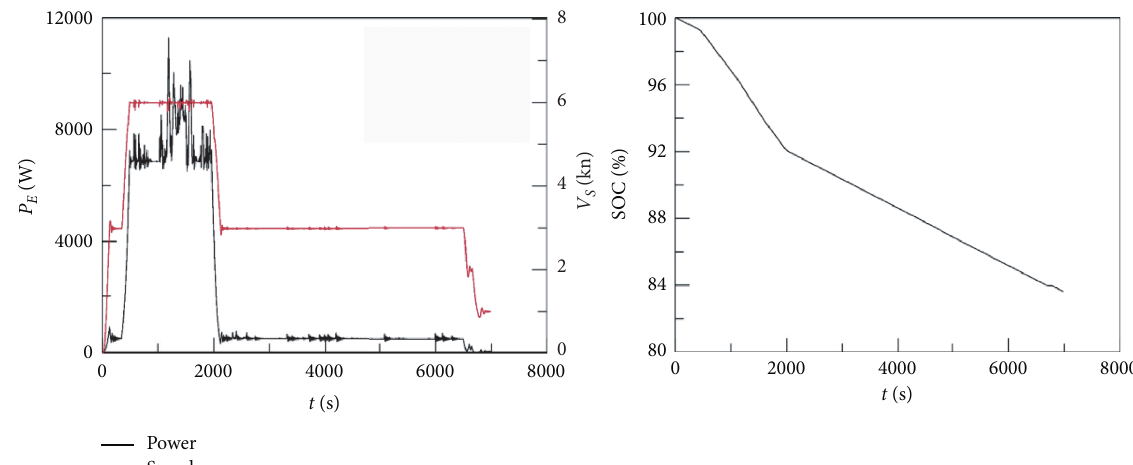
Figure 13: Results of the simulation on Route 1, highlighting speed, power, together with batteries